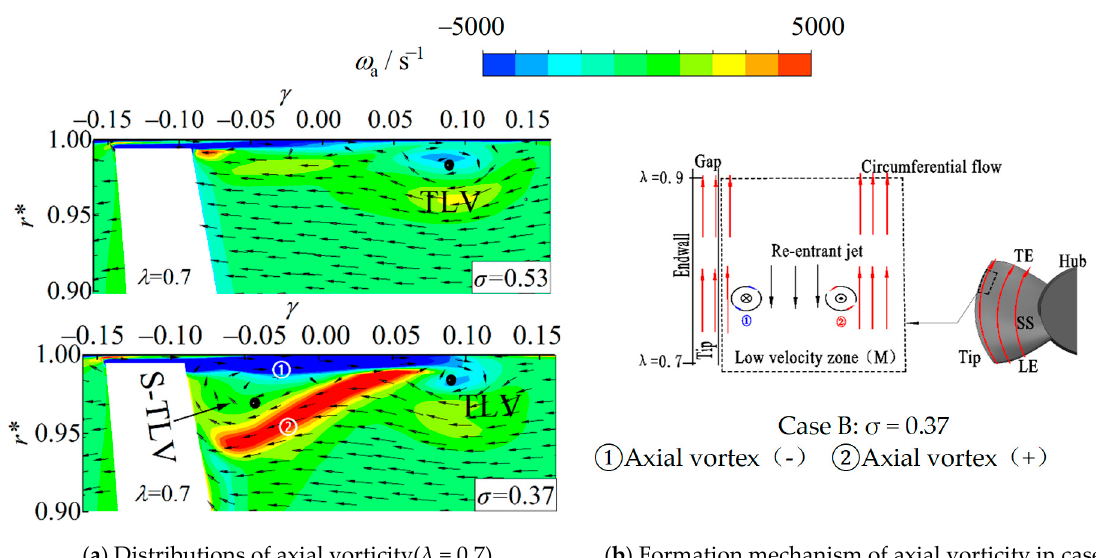
Figure 19. ( a , b ) Axial vorticity distributions in the section of λ = 0.7 and its formation mechanism.